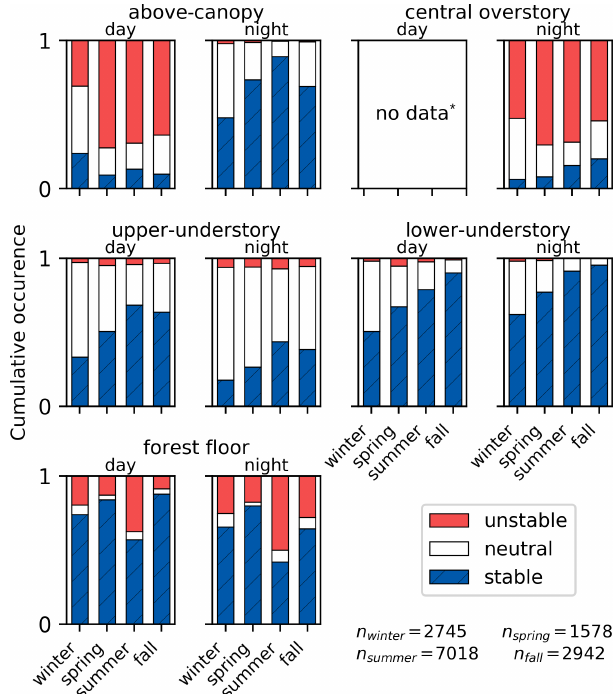
Figure 5. Comparison of the local static stability of each cable section (above-canopy, central overstory, upper-understory, lower- understory, forest floor) over time. The y axis shows the cumula- tive occurrence of stable, neutral, and unstable conditions. Results are split over daytime (left) and nighttime (right) and aggregated over the different seasons. * Central overstory daytime data are not shown due to errors created by solar